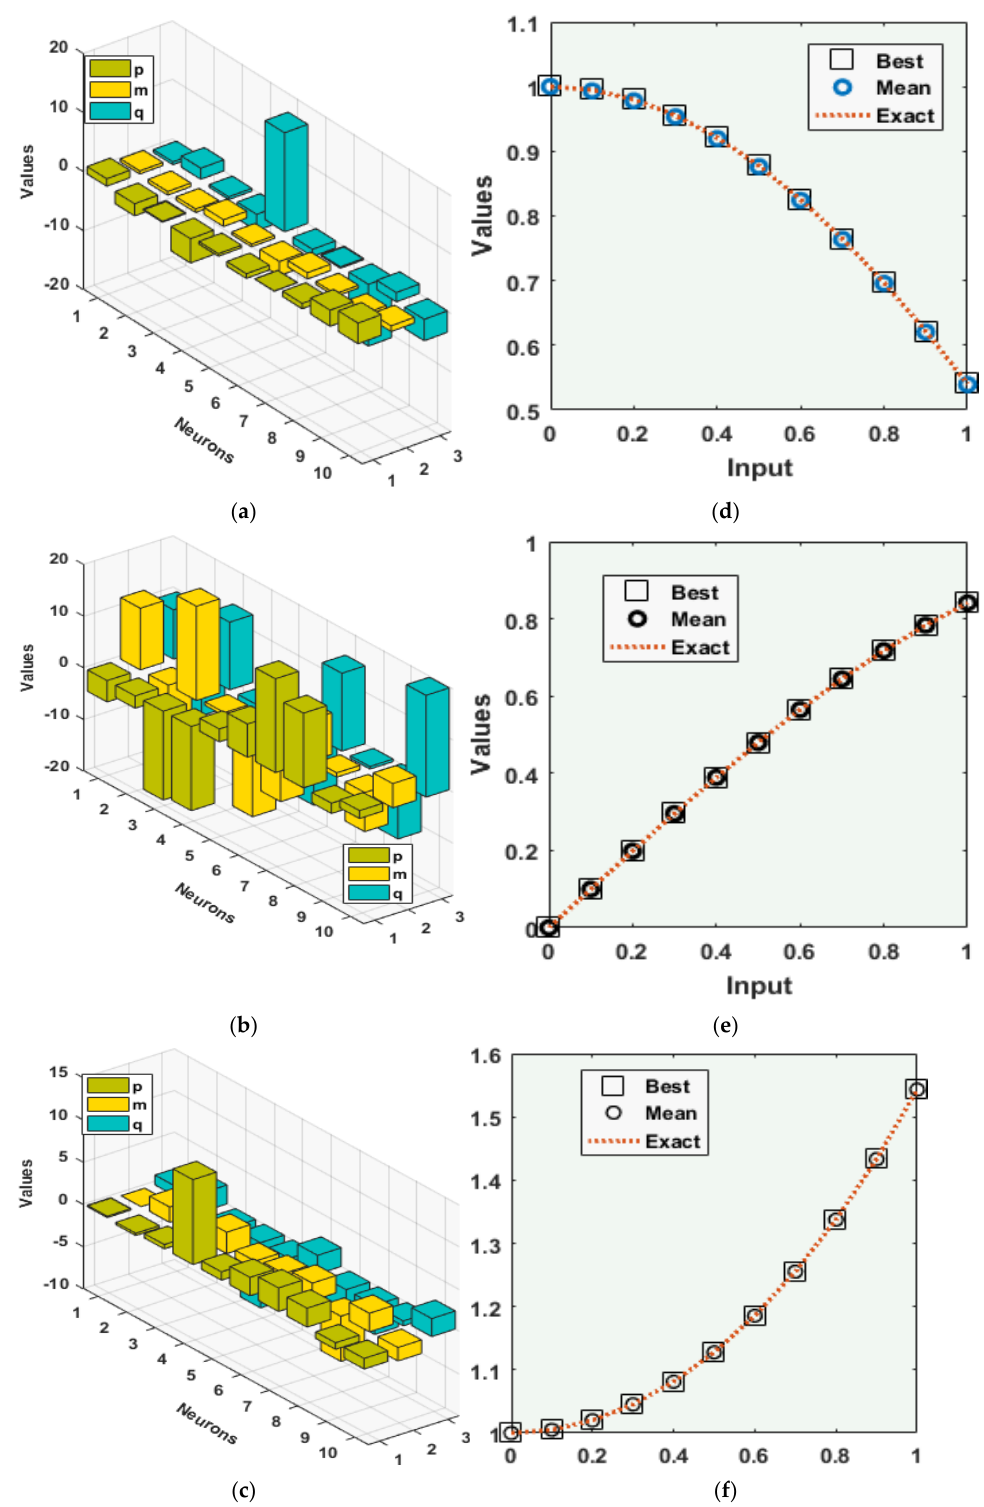
Figure 2. ANN best weights and result comparisons using the ANN-GAASM for Problems 1 to 3 based on the second kind of NLE-PDSM. ( a ) ANN weights based on Problem 1. ( b ) ANN weights based on Problem 2. ( c ) ANN weights based on Problem 3. ( d ) Result comparison for Problem 1. ( e ) Result comparison for Problem 2. ( f ) Result comparison for Problem 3.